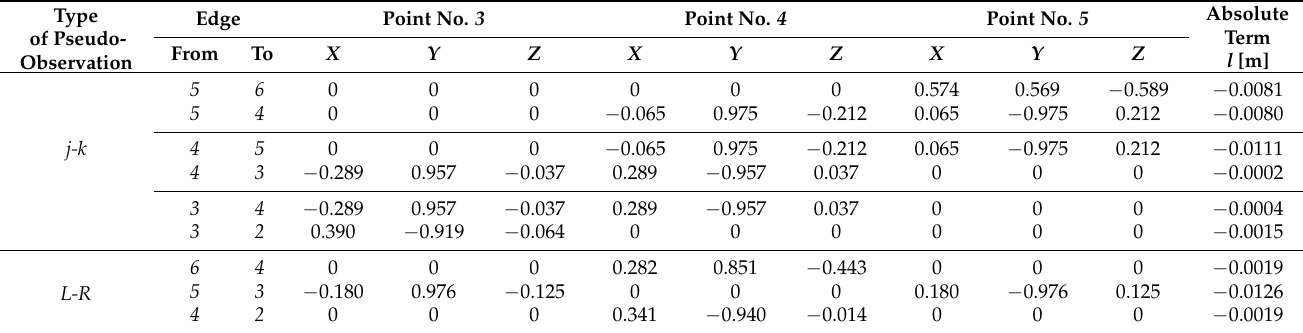
Table 5. Coefficients at the unknowns (partial derivatives) and the absolute terms (13), (16) in the equations of corrections for the pseudo-observations (12), (15).